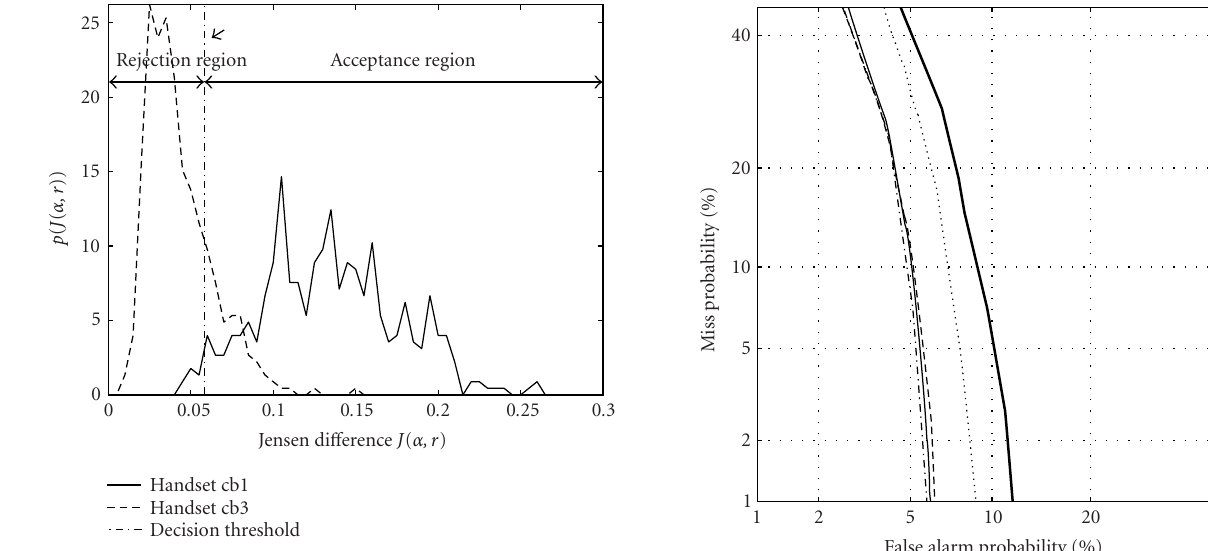
Figure 2: The distribution of the Jensen Di ff erence J ( (cid:1) α , (cid:1) r ) corre- sponding to the seen handset cb1 and the unseen handset cb3.